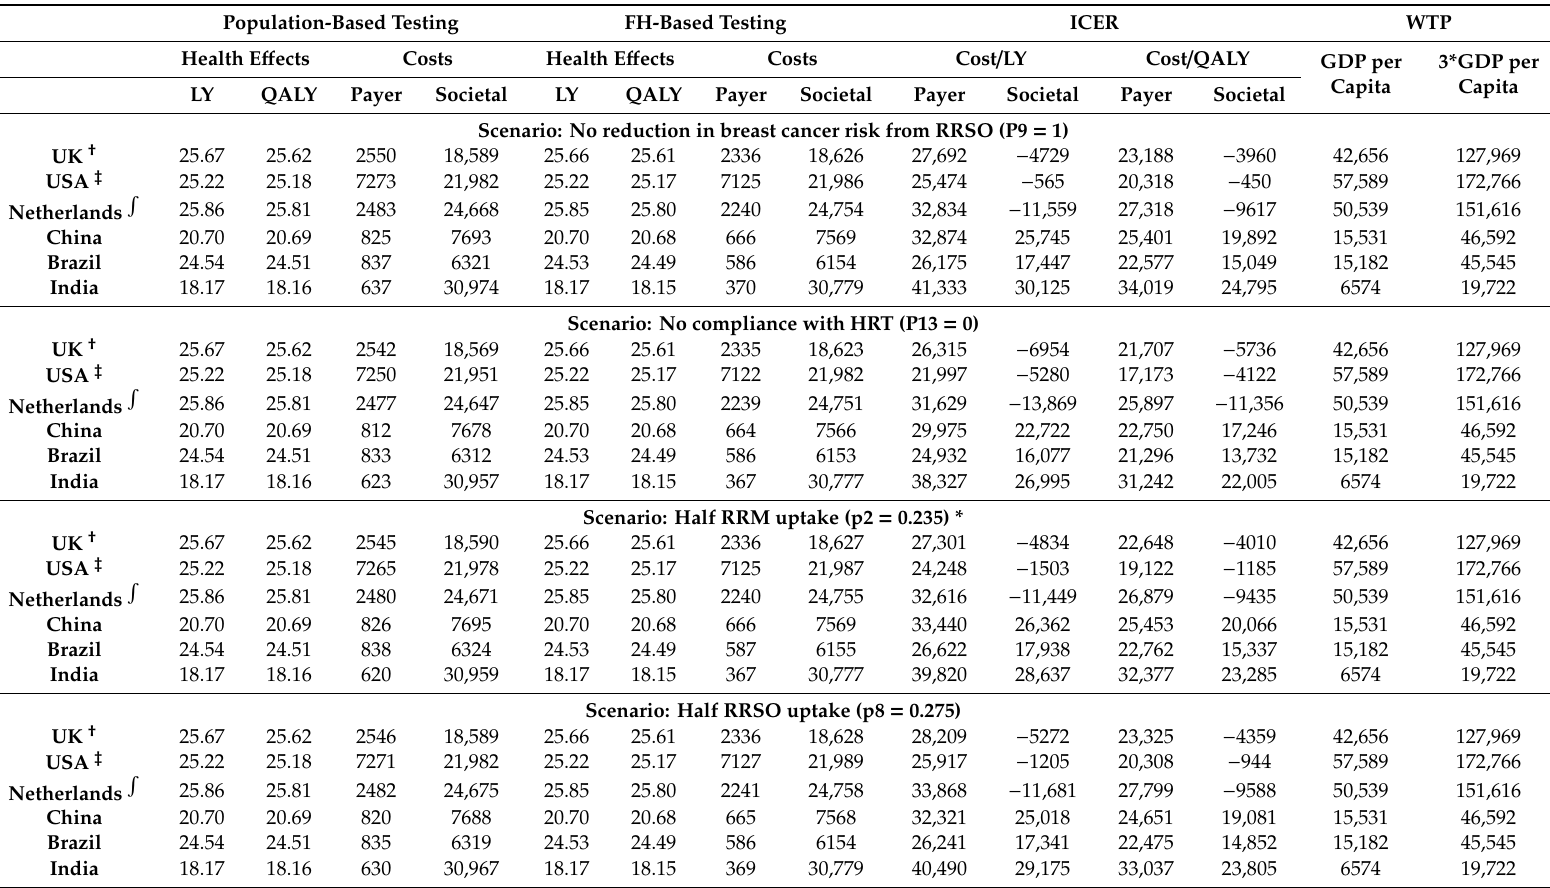
Table 3. Scenario